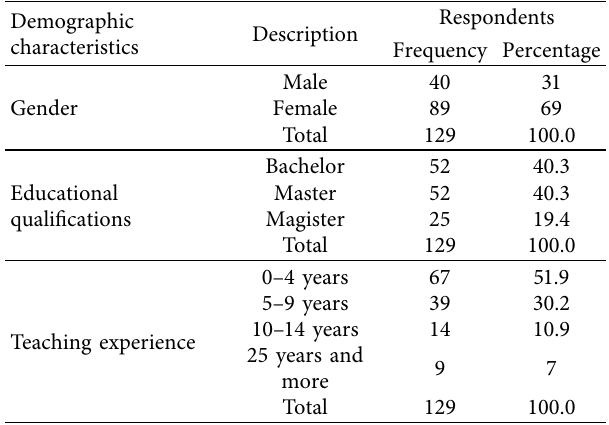
Table 1: The demographic characteristics of the participants (made by the